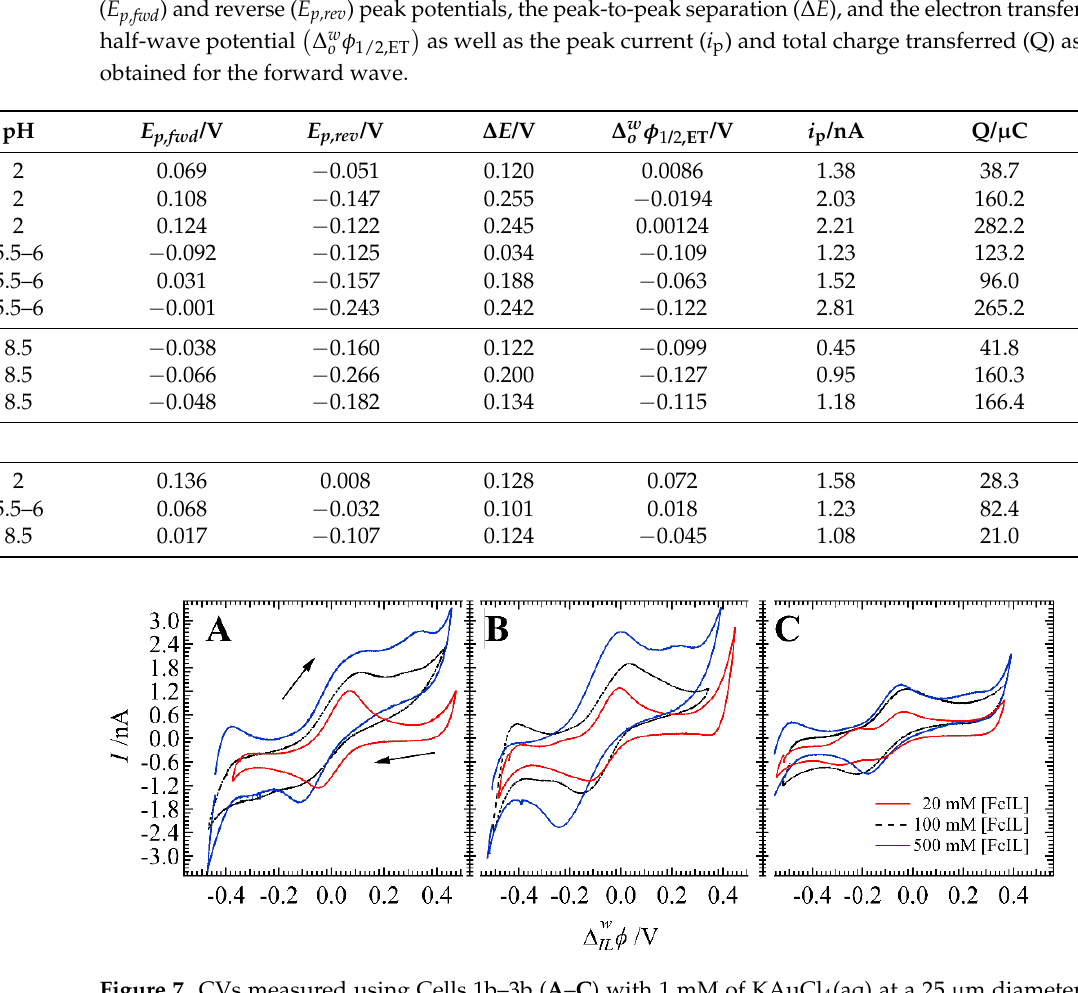
Figure 7. CVs measured using Cells 1b – 3b ( A – C ) with 1 mM of KAuCl 4 (aq) at a 25 µm diameter interface, 0.020 V s – 1 , and 60 °C, with increasing concentrations of FcIL added to the P 8888 TB phase, as indicated inset.